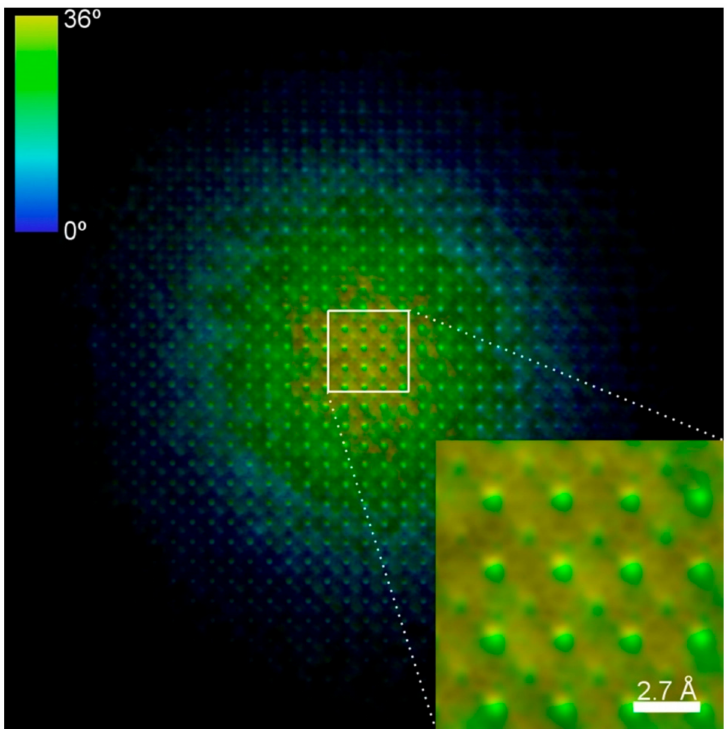
Figure 6. Retrieved image by MPR for the KEDI experiment in Figure 3. Here the brightness is proportional to the retrieved modulus whereas the colors represent the retrieved phases. (Reprinted with permission from Colombo et al.